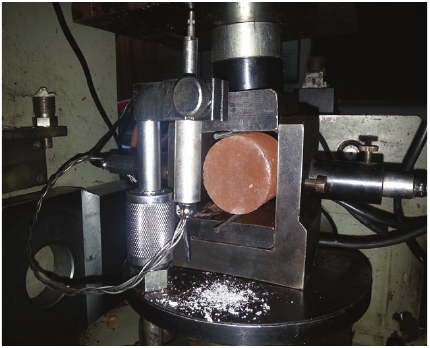
Figure 2: Photo of salt rock specimens on loading.